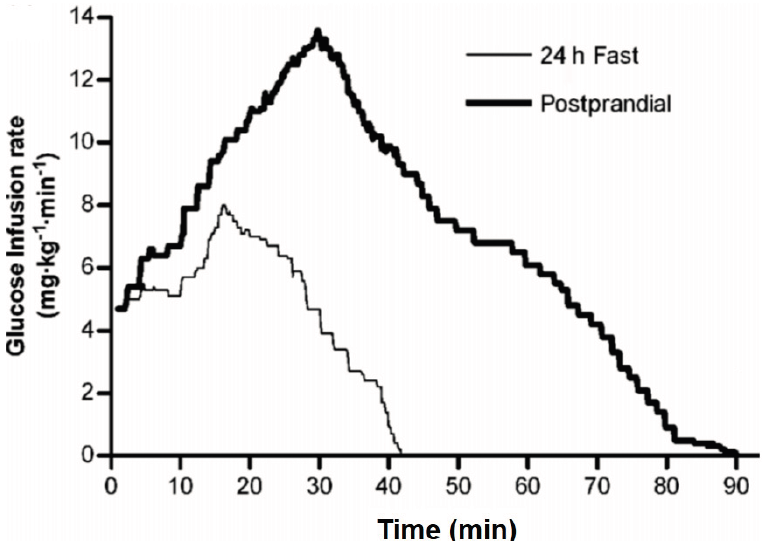
Figure 1. Rapid Insulin Sensitivity Test (RIST) in fasted and fed humans. The rate of glucose infusion required to maintain euglycemia is shown for healthy male volunteers after administration of a bolus of 50 mU/kg insulin in the 24 hours-fasted state. The mean RIST curves were obtained by averaging glucose infusion rates at 0.1 minutes intervals. The RIST was repeated 100 minutes after consumption of a mixed test meal. The